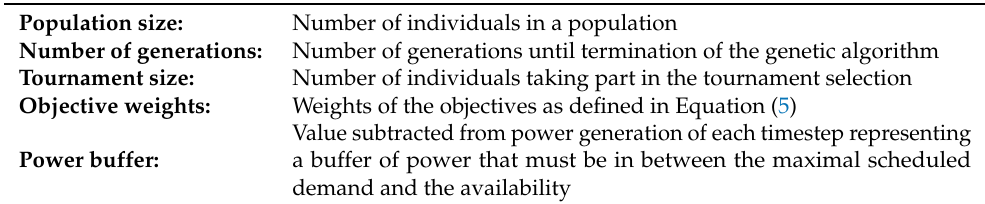
Table 4. Parameters used in the genetic